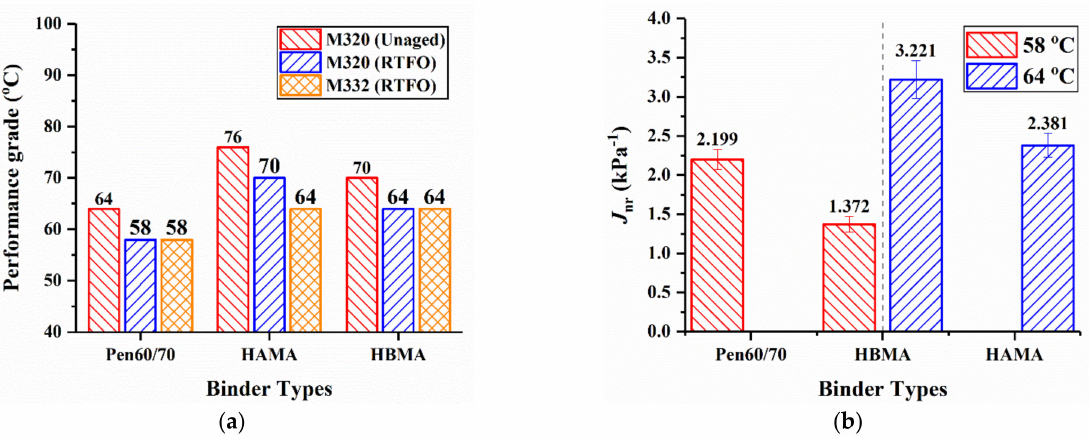
Figure 8. Comparison of MSCR results: ( a ) Performance grade and ( b ) J nr